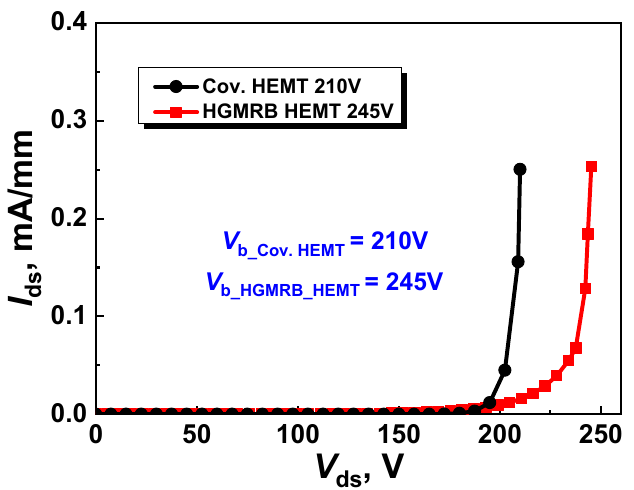
Figure 4. Breakdown characteristics of the two devices at V gs = V t .